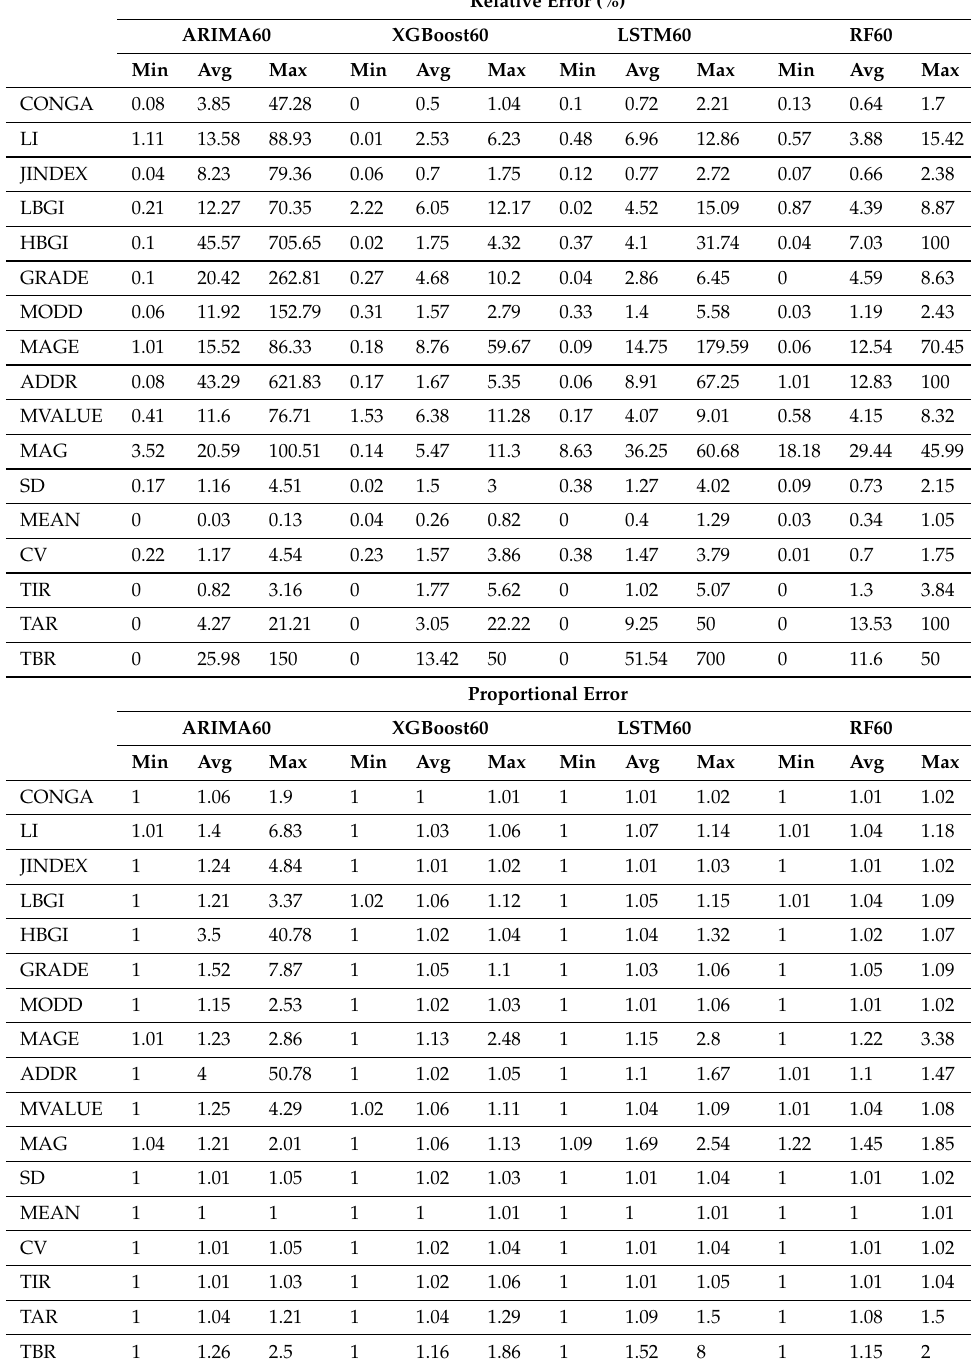
Table A2. Relative and proportional errors for glucose variability metrics calculated using 48 h of glucose profiles predicted using ARIMA, Gradient Boost, LSTM, and Random forests models employing 60 days of training